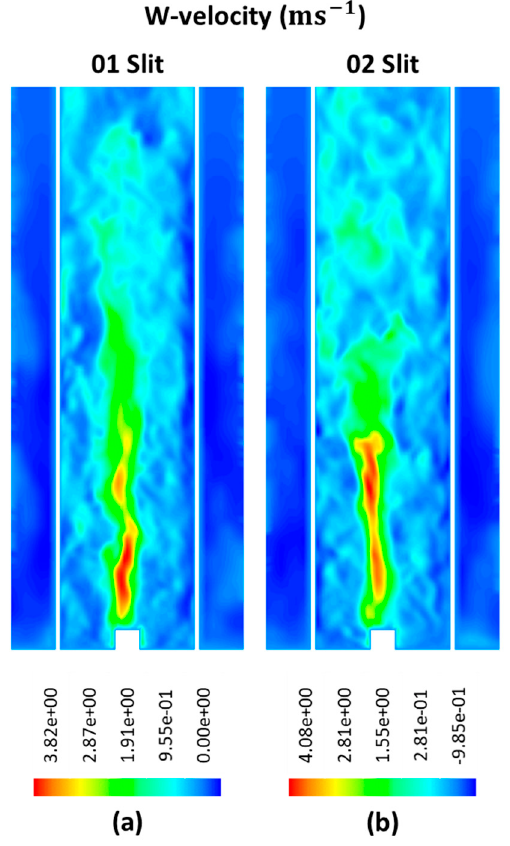
Figure 13. Axial velocity contour of a cross-sectional plane of the 01 slit case ( a ), and the 02 slit case ( b ).